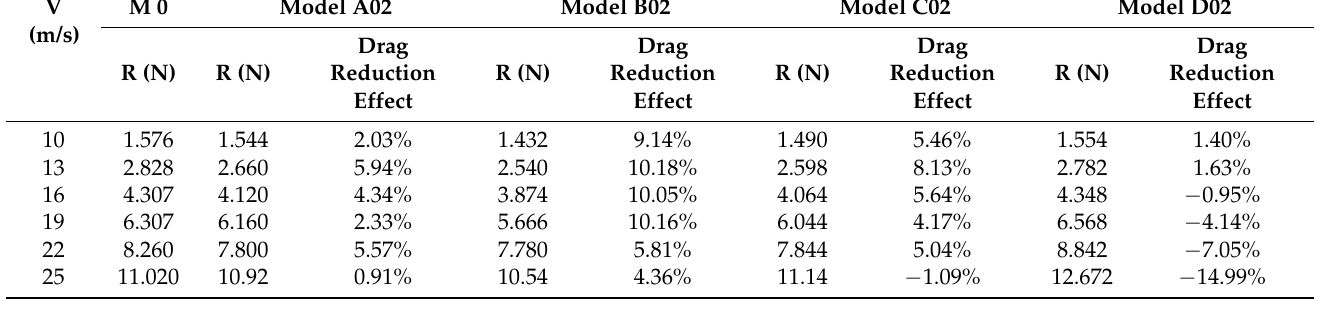
Table 6. Resistance and drag reduction effect of square stern model.